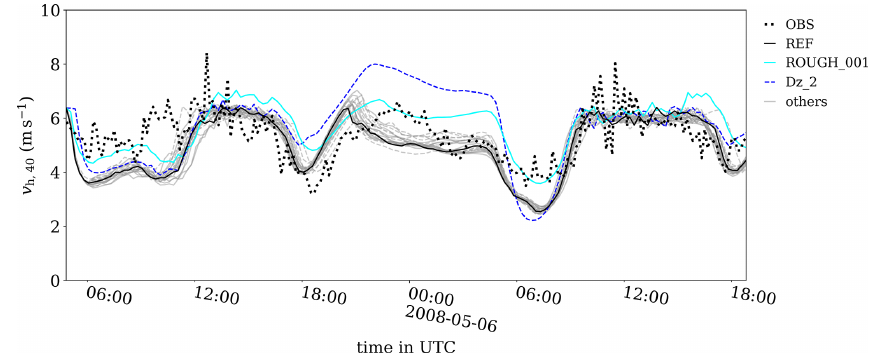
Figure 13. Time series of mean horizontal wind speed at 40m as measured at Cabauw (OBS) and for all cases listed in Table 5. Only case REF and some relevant cases are highlighted; all others are shown in